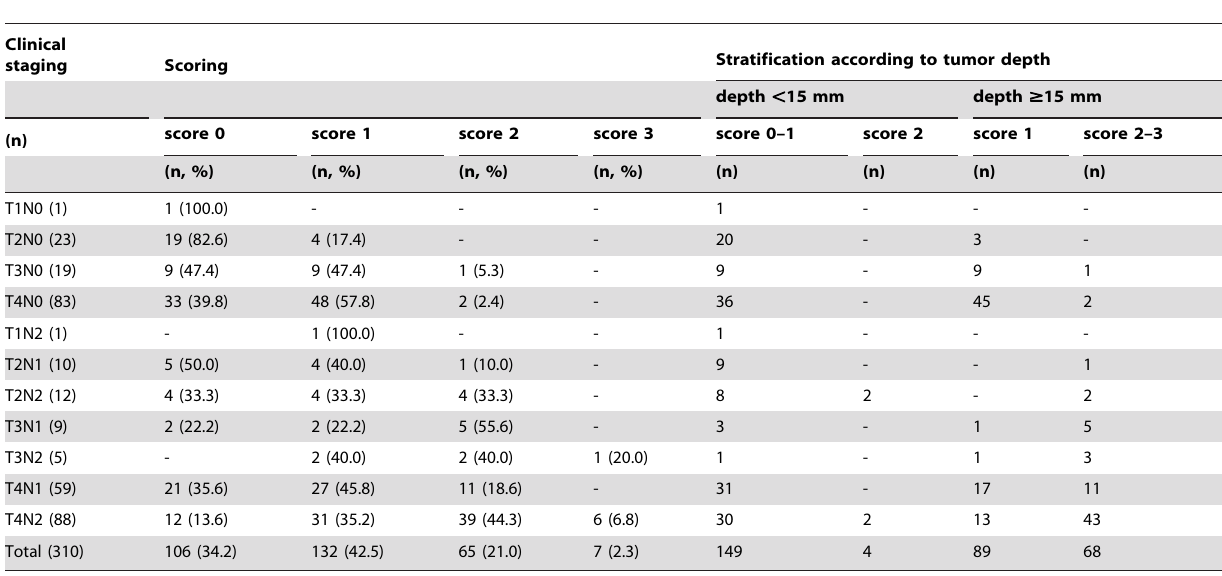
Table 3. Scoring system of OSCC patients in different clinical stages with and without stratification for tumor depth (cut-off: 15 mm).